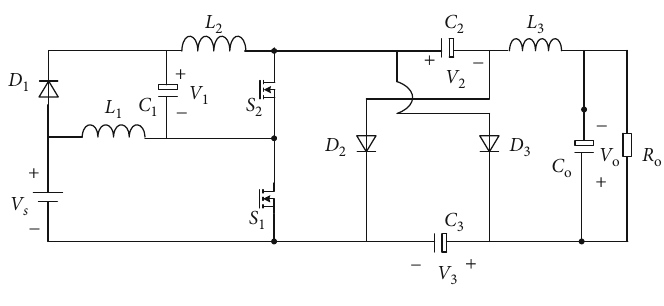
Figure 4: Proposed converter.